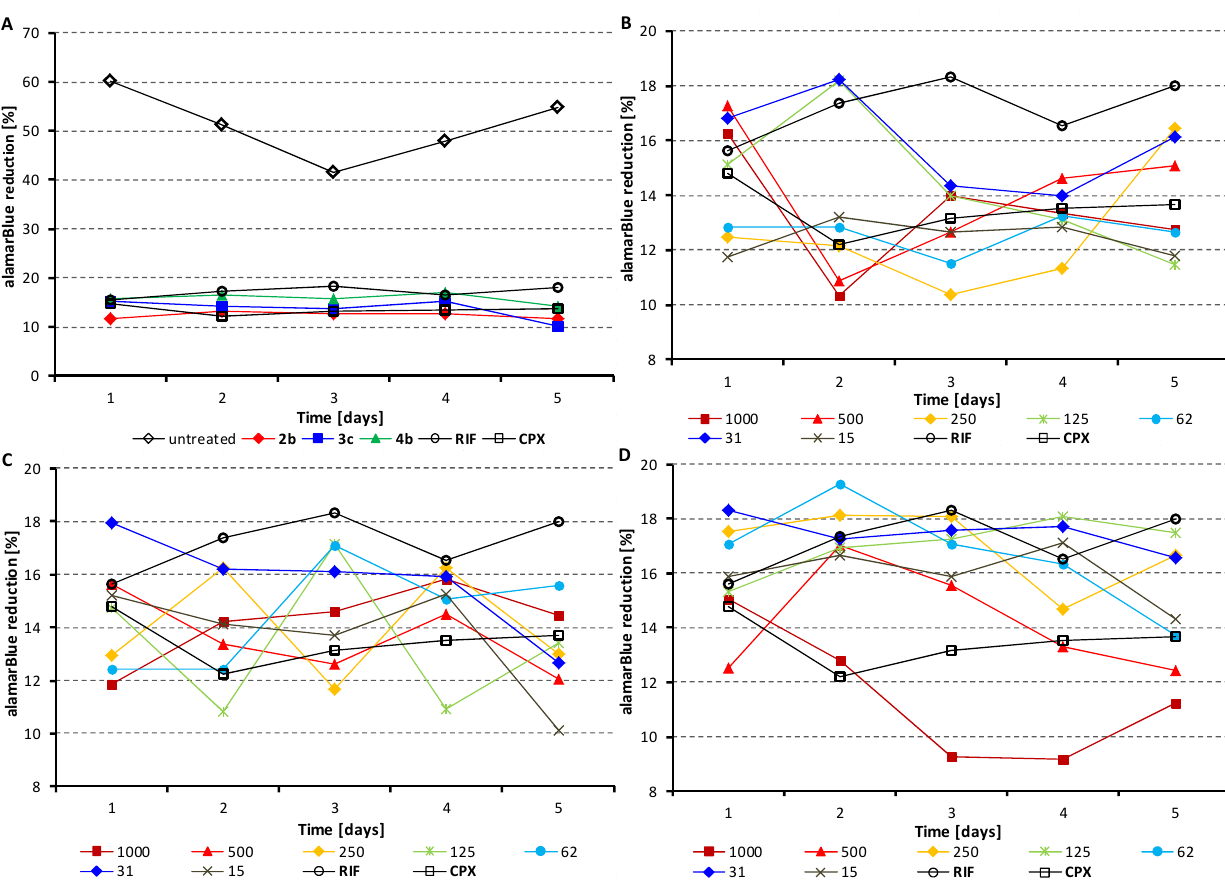
Figure 3. Viability of M. avium subsp. paratuberculosis expressed as percent reduction